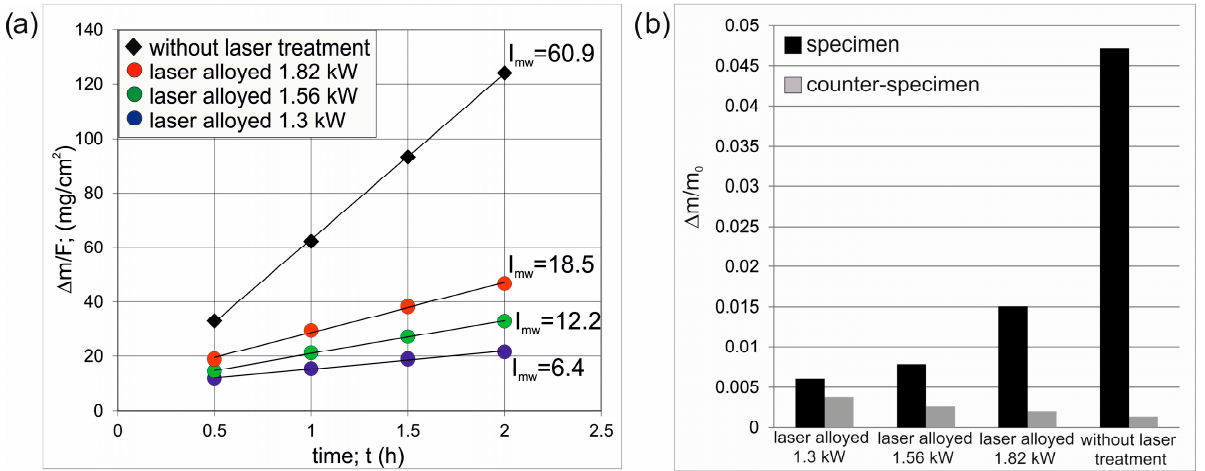
Figure 12. Results of wear resistance tests: ( a ) mass loss of specimens on a unit of friction surface vs. time of friction with calculated I mw factors, ( b ) relative mass loss of specimens and coun- ter-specimens.